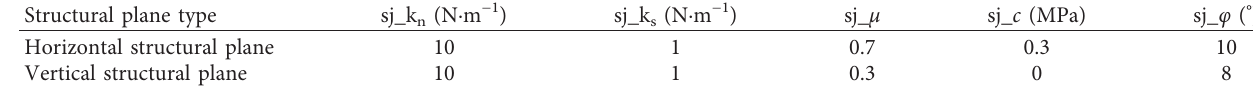
Table 6: Mesoscopic parameters of structural